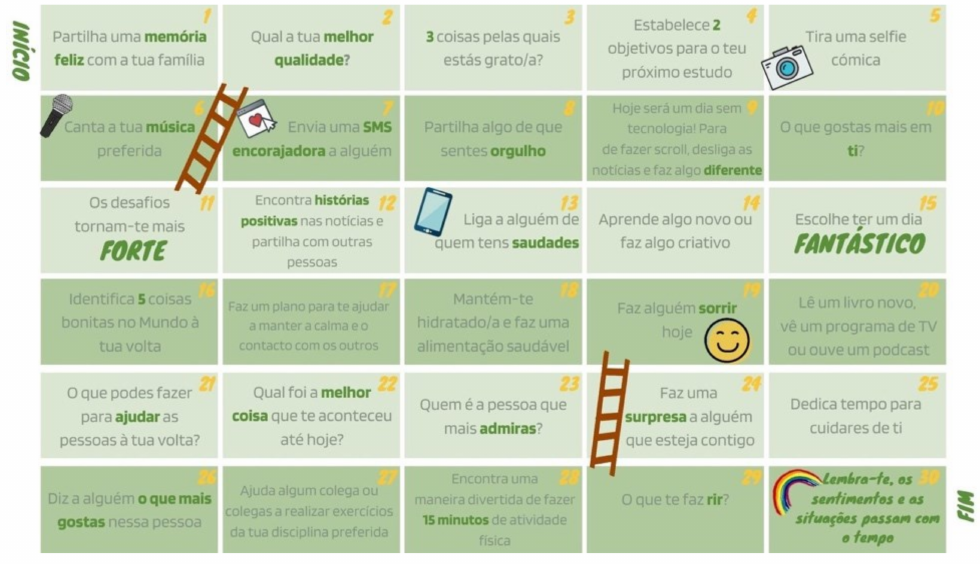
Figure 4. The final integrative